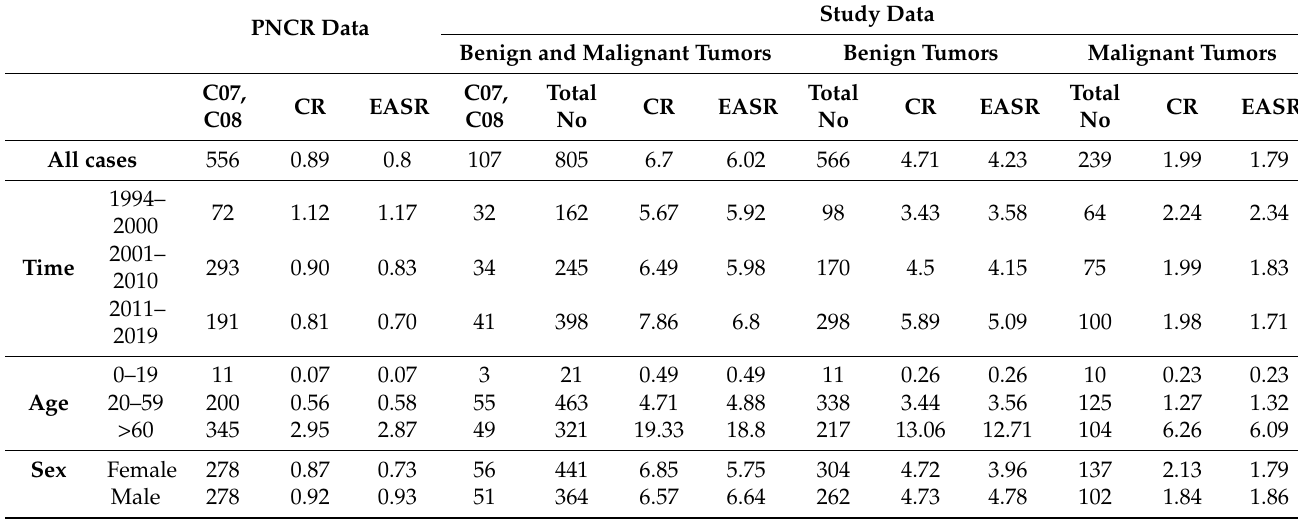
Table 6. Crude and European age-standardized incidence rates (per 100,000) for salivary gland tumors in southern Poland. PNCR